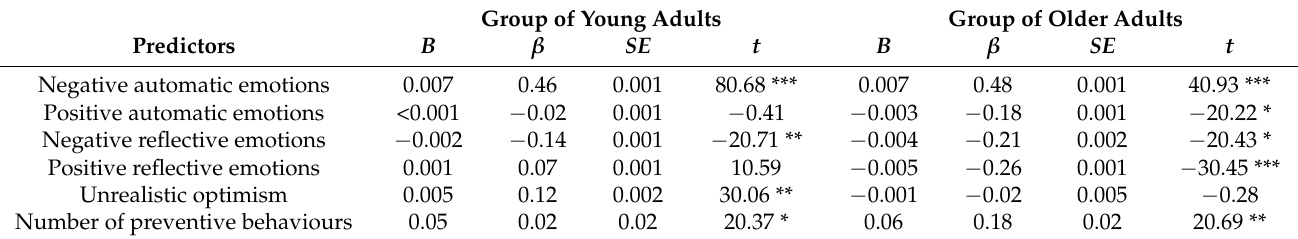
Table 2. Regressions for dependent variables of general anxiety with participants divided into two groups: young adults and older adults. The asterisks symbolize the level of statistical